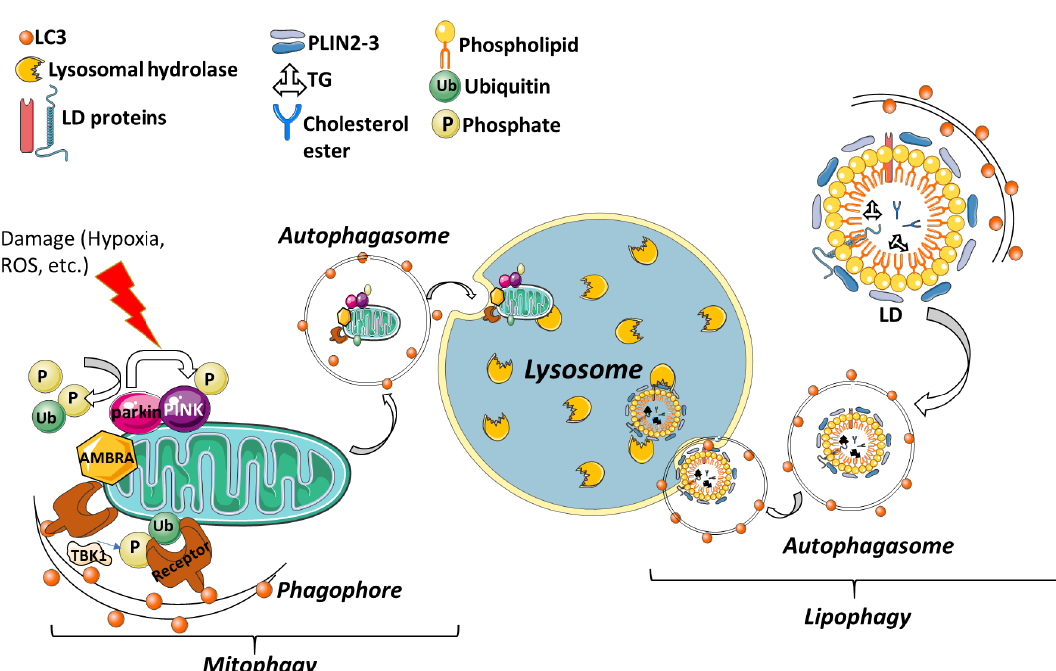
Figure 3. Selective autophagy degrades nonfunctional organelles and lipid droplets engulfed by double membrane vesicles. Non-functional or damaged mitochondria or lipid droplets are enclosed by phagophore then they are directed through lysosome for recycling.